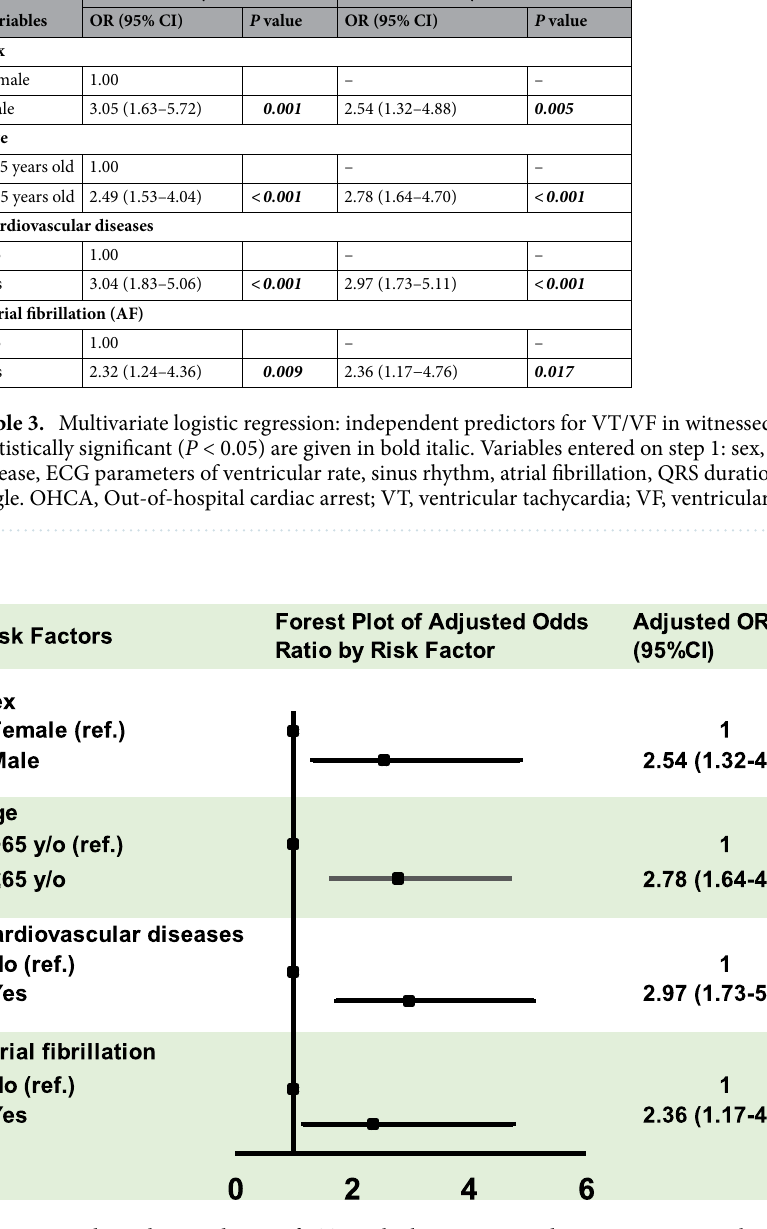
Figure 2. Independent predictors of VT/VF rhythm in witnessed OHCA patients. Males, age ≤ 65 years old, a past history of cardiovascular diseases, and ECG of AF rhythm closest to the OHCA event were independent risk factors for witnessed VT/VF OHCAs identified by using multivariate logistic regression